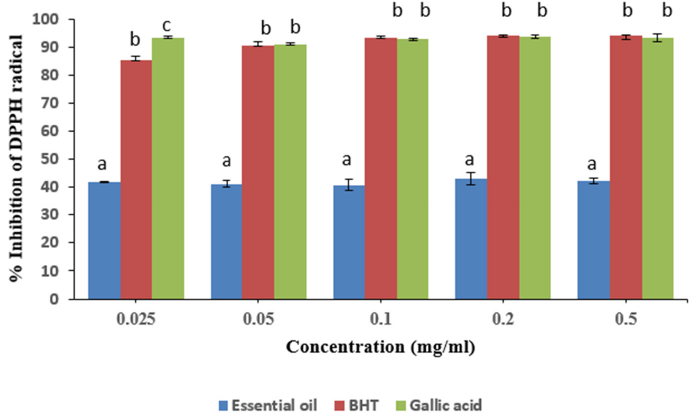
Figure 2. DPPH radical scavenging activity of the essential oil of H. africana. Bar graphs with different letters within the same concentration are significantly different ( p < 0.05).